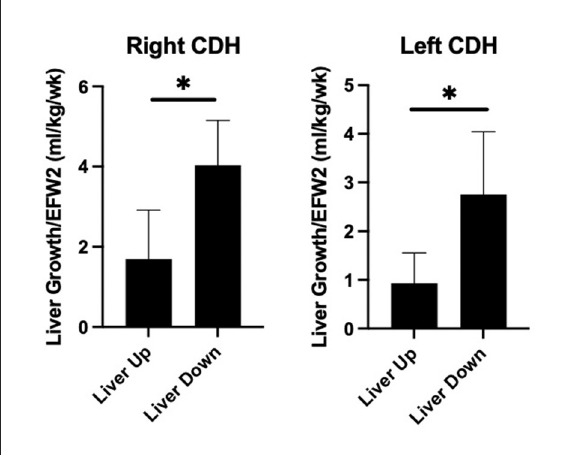
FIGURE2 Greater liver growth below the diaphragm in prenatal CDH. Comparison of fractional liver growth (liver up and liver down) normalized to late gestation estimated fetal weight in right and left sided CDH fetuses. As shown, liver growth below the diaphragm is greater than the growth above the diaphragm in both right and left sided CDH (* p <